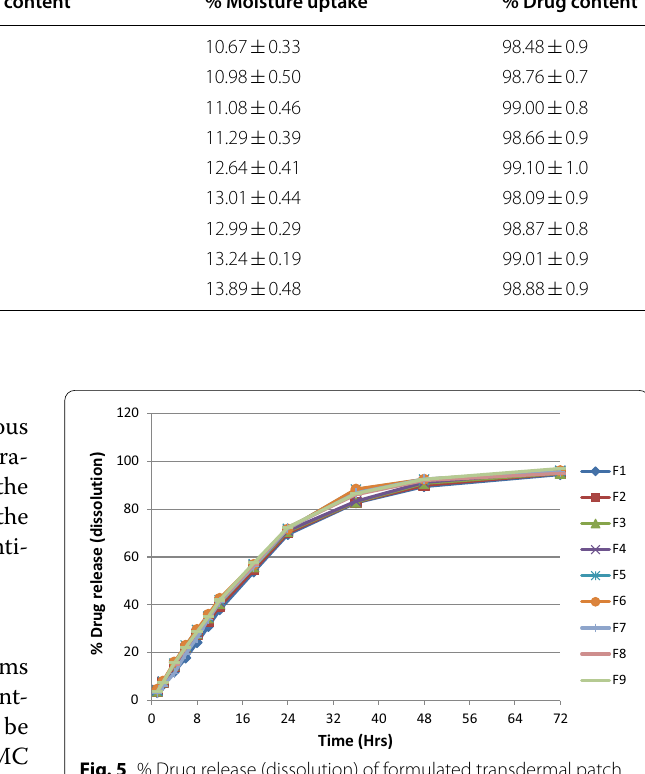
Table 6 Data for various evaluated parameters of transdermal patch (F1–F9) Batch code Surface pH